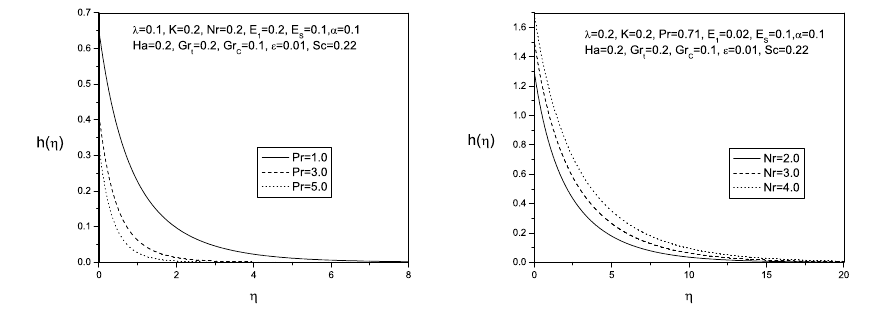
Figure 6. Variation of temperature profiles with η for different values of Pr .